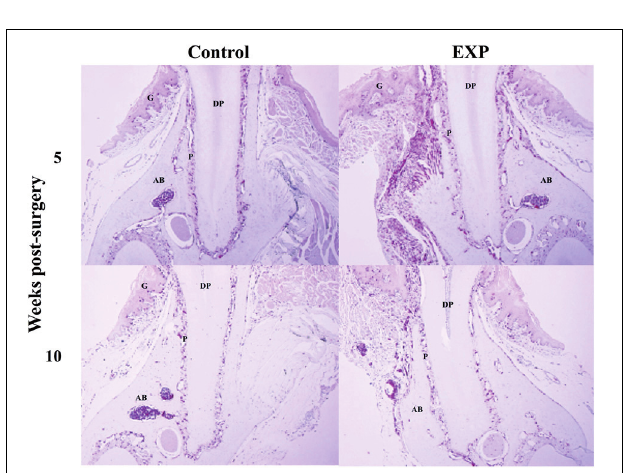
the periodontal ligament (C) , blood vessels (D) , and dental pulp (E) . A, multinucleated giant cells in resorption lacunae of alveolar bone; B, gingival epithelium; C, periodontal ligament; D, blood vessels in periodontal ligament; E, dental pulp. G, gingiva; AB, alveolar bone; P, periodontal ligament; DP, dental pulp; D, dentin.